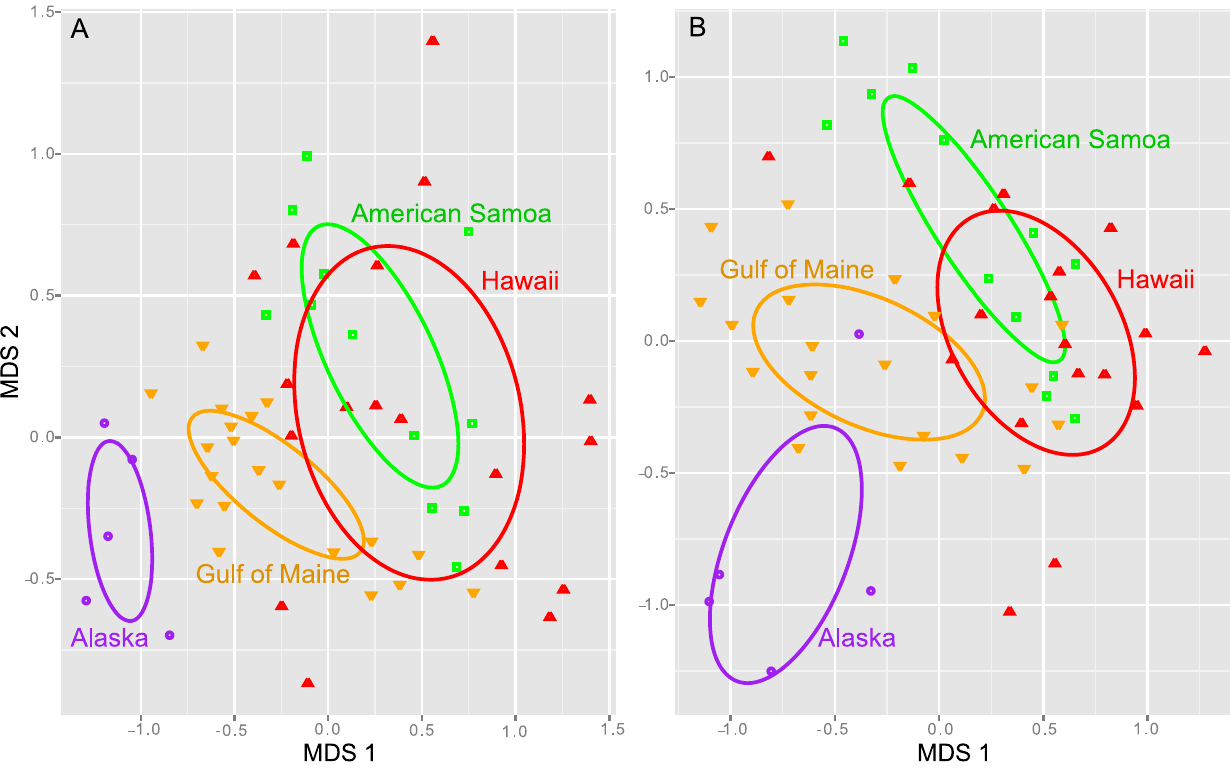
Figure 6. Oligotyping analysis of major humpback skin-bacterial groups. MDS analysis of the healthy animals from four regional groups based on Tenacibaculum (A) and Psychrobacter (B) oligotypes. Centroid and shape of each ellipse is defined by the distribution and standard deviation of points in the defined regional groups.